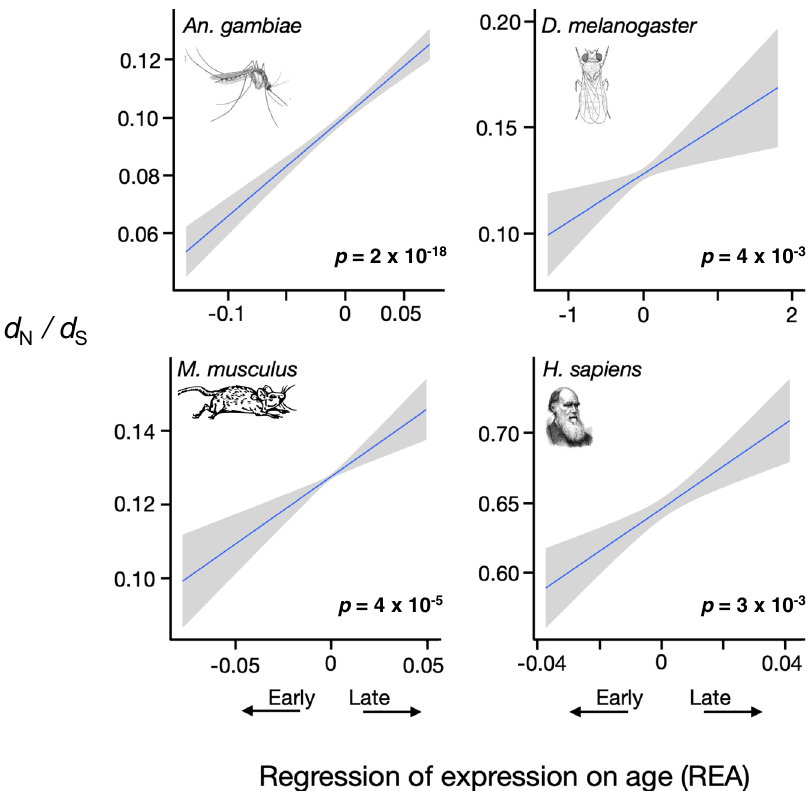
Fig. 1 Late genes fi x nonsynonymous mutations at higher rates. Genes expressed later in life fi x nonsynonymous mutations at a signi fi cantly higher relative rates than those expressed early, as measured by the d N / d S ratio, in mosquitoes, fl ies, mice, and humans. Signi fi cance was determined by Spearman rank correlations, and p -values in bold are signi fi cant at p < 0.05 (two-sided tests, not corrected for multiple tests). The lines are least squares regressions, and the gray regions show the approximate 95% con fi dence intervals for the regressions. See also Supplementary Fig. 1 and Supplementary Table